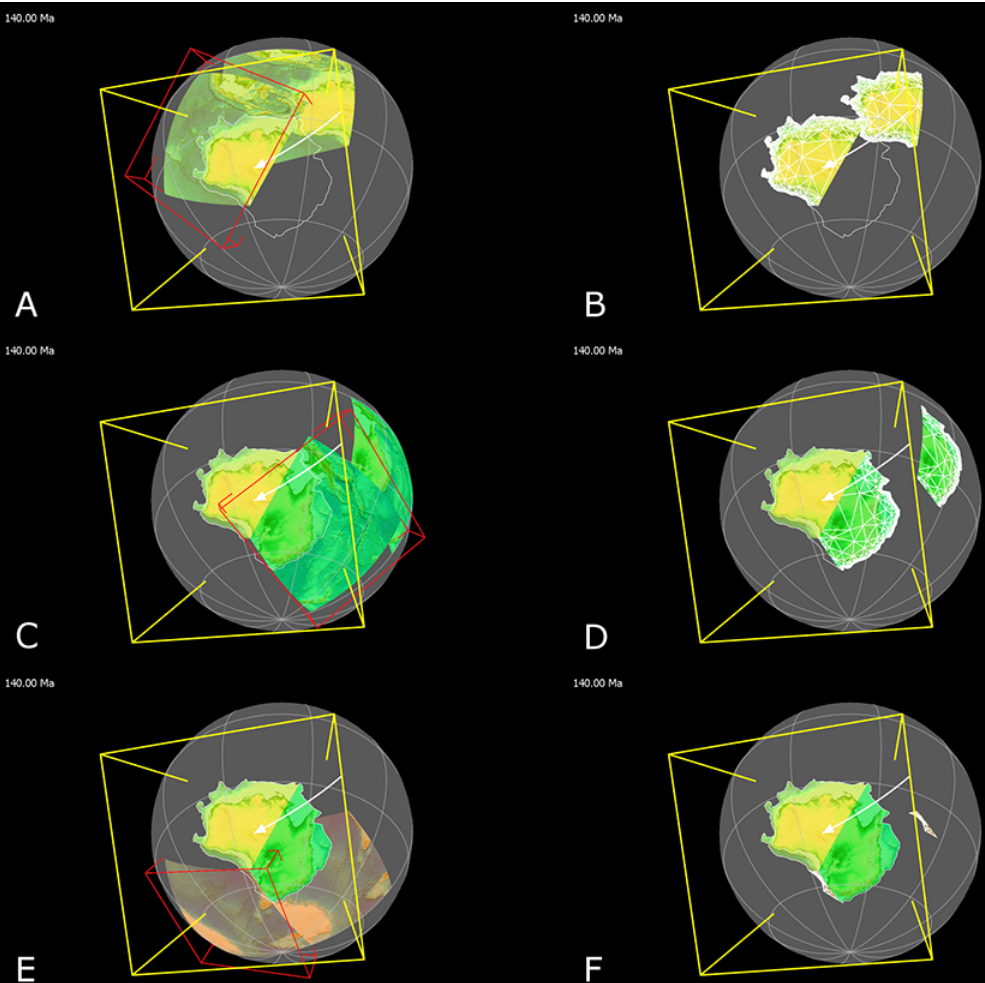
Figure 8. Accumulated tile rendering of single rotated polygon mesh (continental crust on the Australian plate) overlapping three cube map raster tiles (at quadtree level 1). The rotation (illustrated by the white curved arrow) is from present day (0Ma) to 140Ma. The yellow wireframe is the orthographic-(rectangular prism) view frustum used by the “3-D Orthographic” view in GPlates. The three tiles are also shown in Fig. 6b in their present-day locations. (A, C, E) show the unrotated and rotated cube map tiles. Also shown are the rotated tile OBBs in red wireframe. All three OBBs intersect the orthographic-view frustum and therefore are visible; (B, D, F) show the unrotated and rotated polygon mesh, in white wireframe, clipped to each